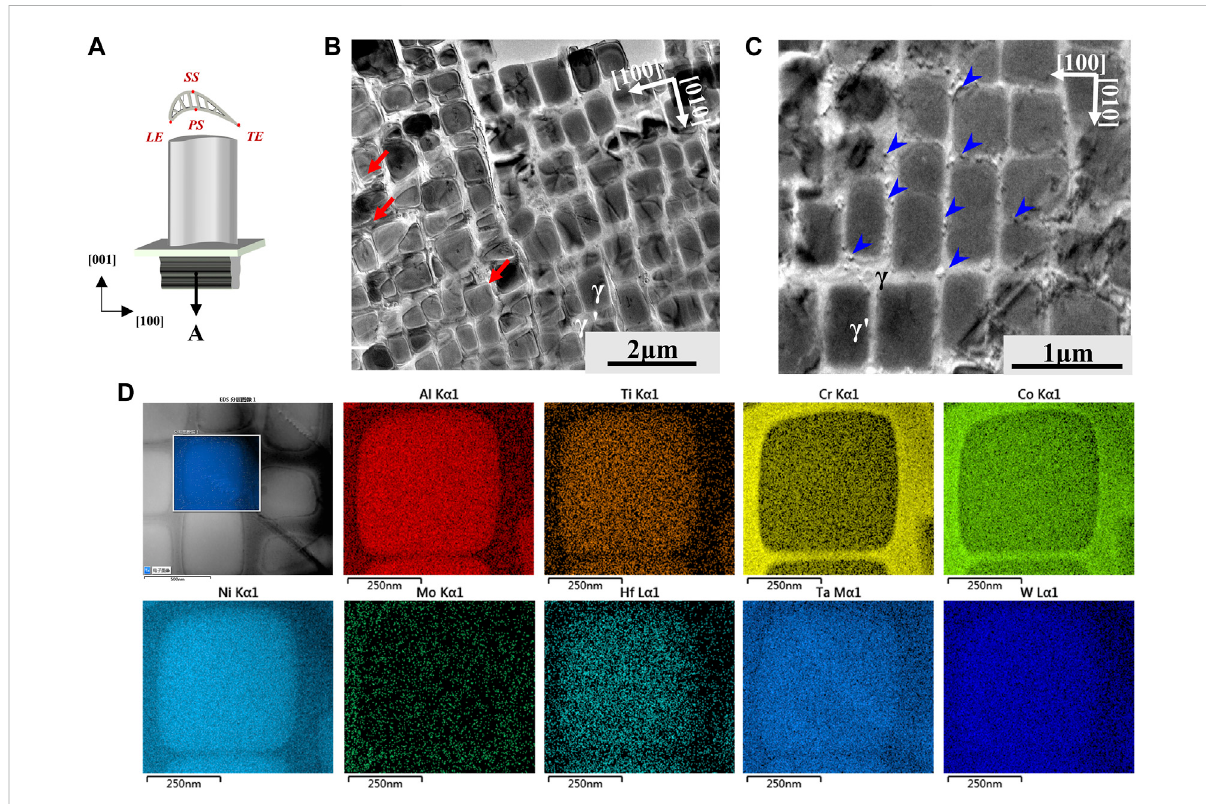
FIGURE 2 (A) ThepositionofpointAontheblade, (B – C) morphologyof γ ′ precipitatesanddislocationsatpointA, (D) elementaldistributionmapsofthe γ and γ ’